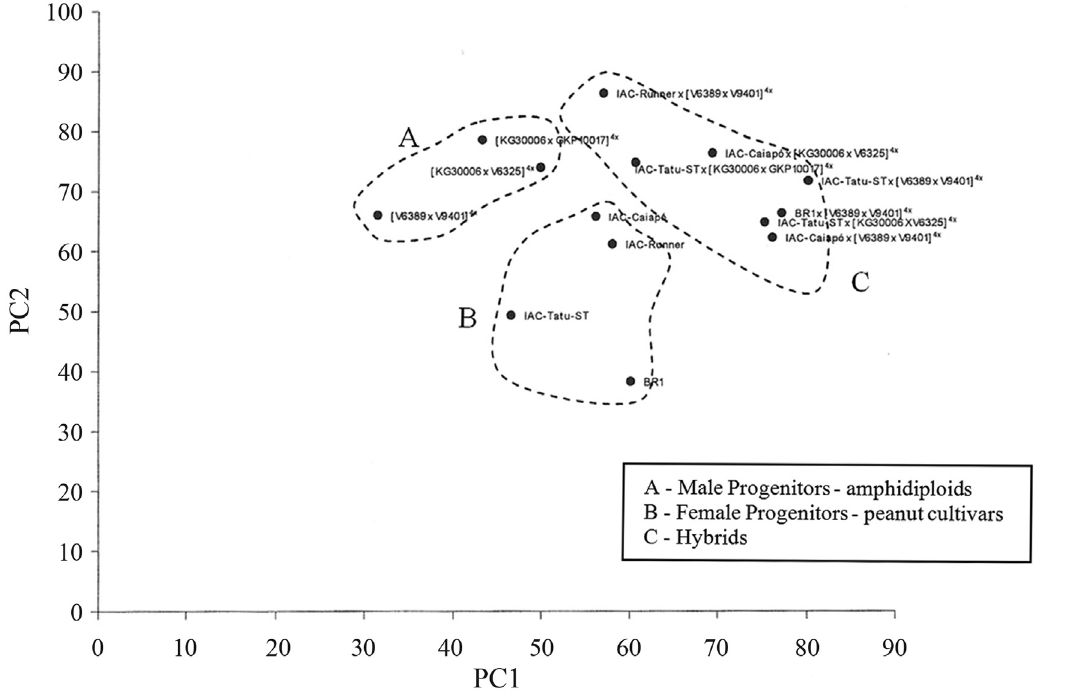
Figure 3 - PCA of F1 hybrids obtained by crossing between amphidiploids and A. hypogaea, and their